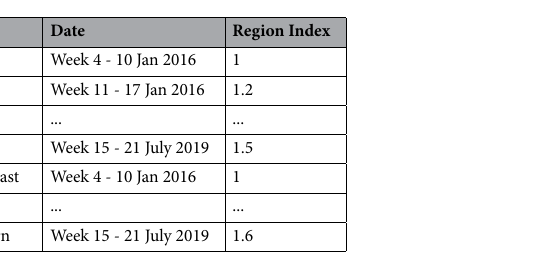
Table 3. Regional Index (RI) of Diagnostic